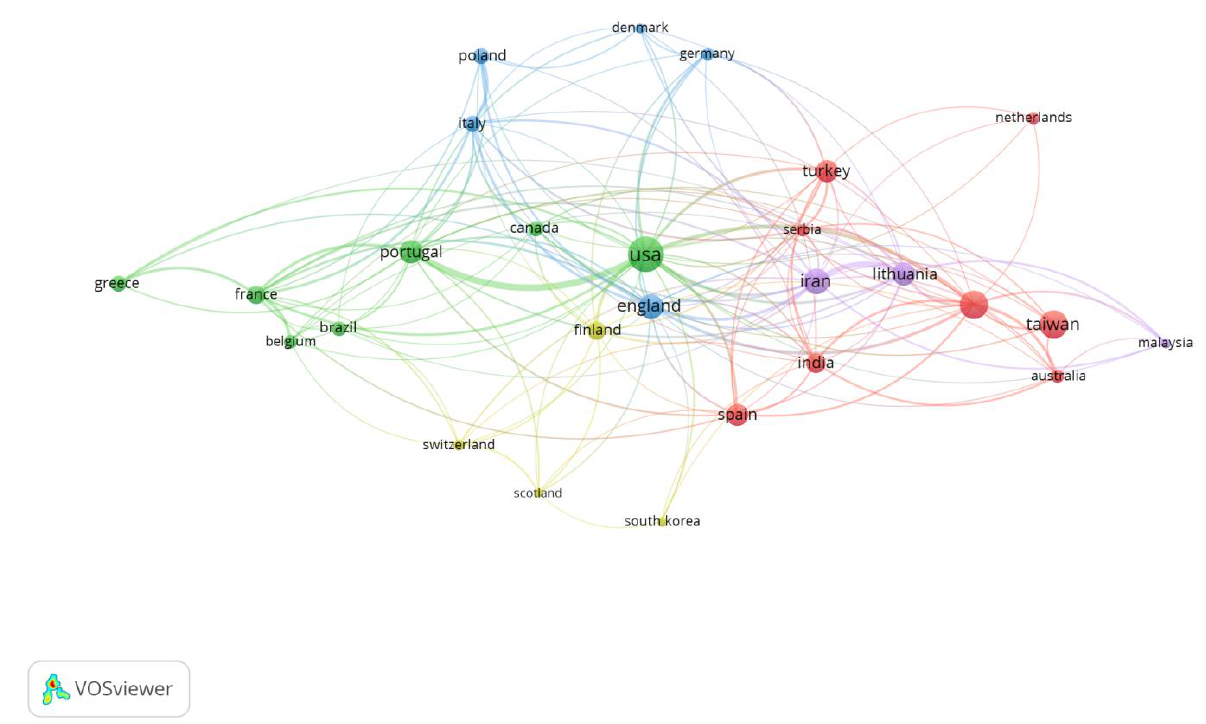
Figure 5. International collaboration networks. The evaluation of academic production reports 27 countries with at least 10 articles for the period analyzed (Table 4). The detailed analysis of academic efficiency places Ser- bia, Netherlands and Denmark above 100 citations per article. Table 4. Collaboration networks in co-authorship. Countries with more than 10 articles.